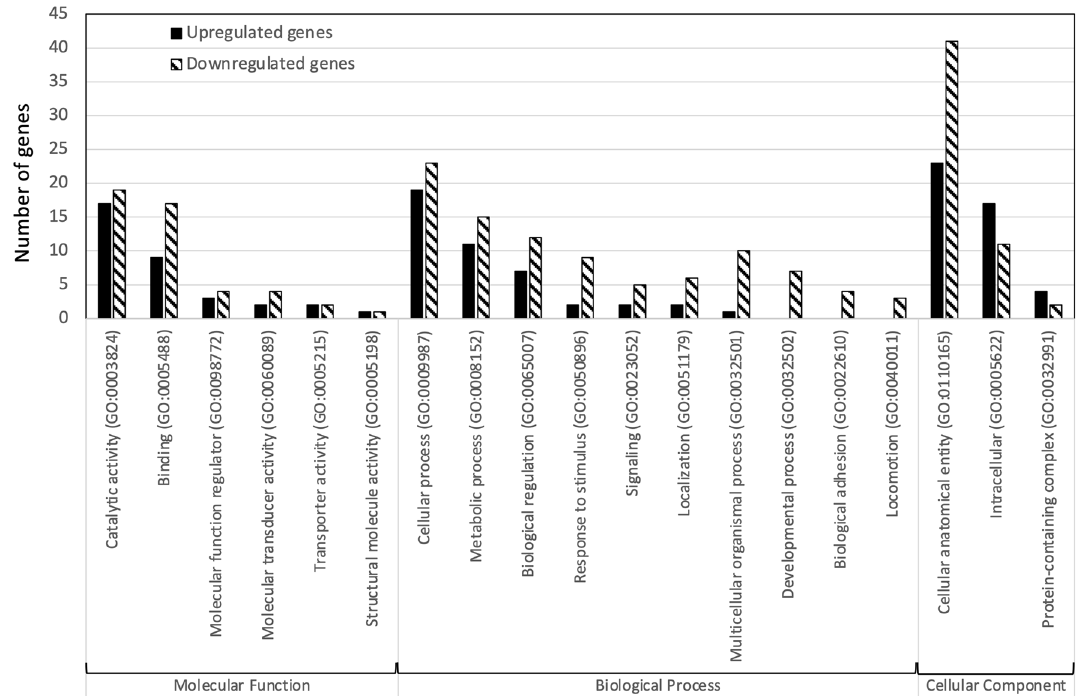
Figure 4. Gene ontology (GO) analysis of differentially expressed genes (DEGs) from DWV-infected honey bee larvae with a fold change (fc) ≥ 2. In total, 909 DEGs were subjected to GO analysis, and 564 DEGs (65.1%) were categorized into three groups—molecular function, cellular component and biological process; however, 318 DEGs (34.9%) were unannotated in the GO database.